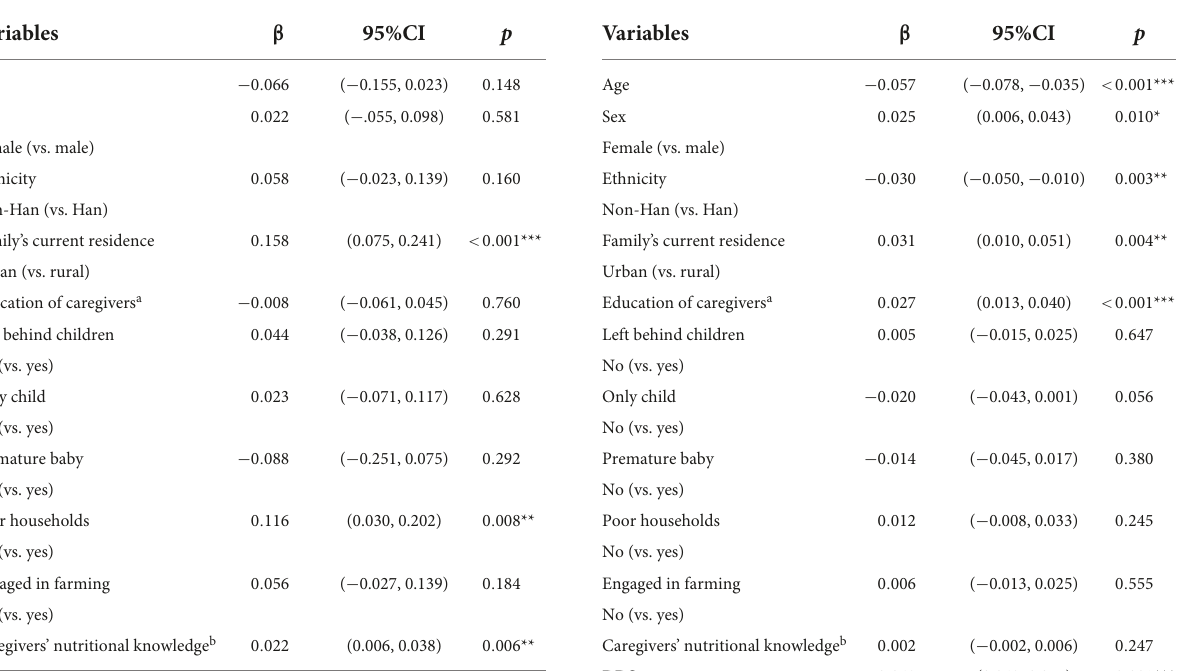
TABLE 4 Poisson regression model of predictors of DDS. TABLE 5 Linear regression model of predictors of